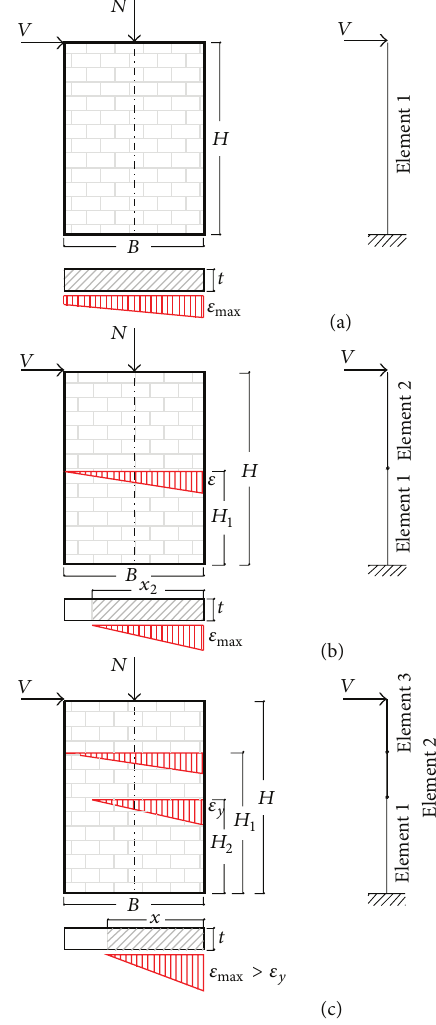
Figure 2: Unstrengthened panels: schemes of assemblage of frame